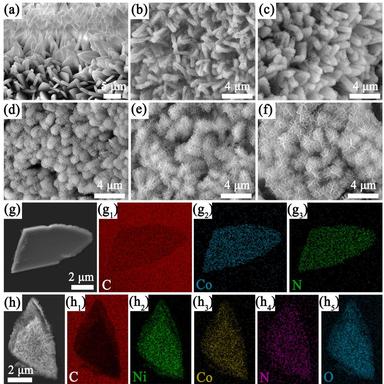
(a) SEM images of ZIF-67. (b-f) SEM images of N/C@Ni-Co LDH with hydrothermal time of 0.5 h, 1 h, 1.5 h, 2 h and 3 h, respectively. (g, h) EDS mappings of ZIF-67 and N/C@ Ni-Co LDH.